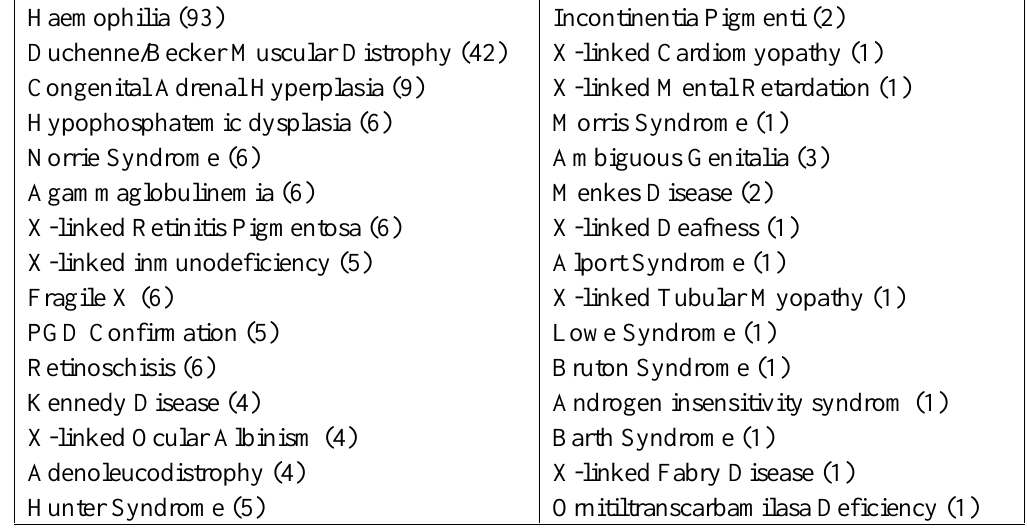
Table 1. Referral reason for sex determination in the 226 pregnancies studied (number of